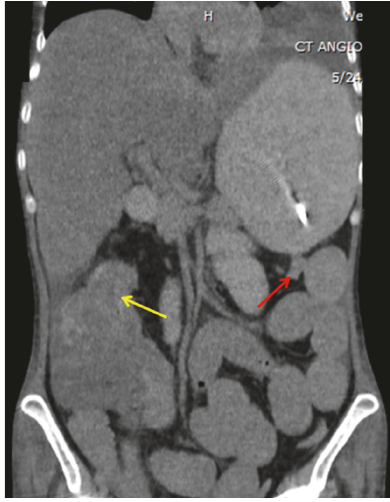
Figure 2: CT demonstrating distal luminal narrowing of bowel loops at both the splenic flexure (red arrow) and hepatic flexure (yellow arrow) with associated bowel wall thickening and edema.